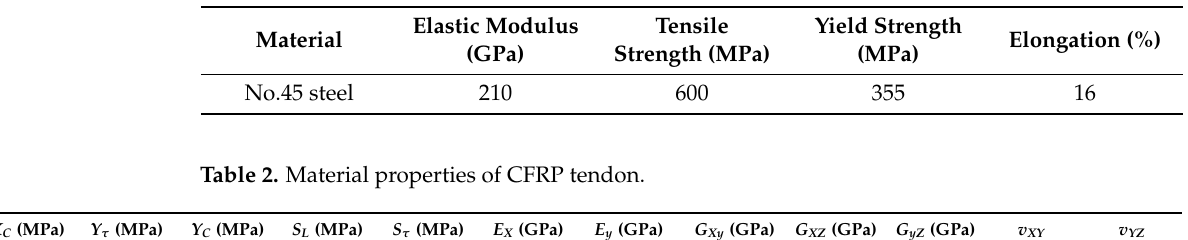
Table 1. Mechanical properties of steel pipe.